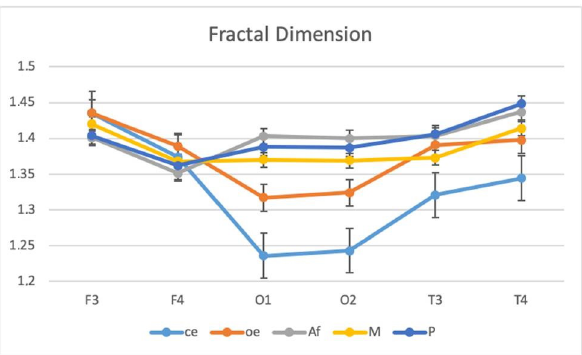
Figure 2. Average values of the fractal dimension in each electrode (F3, F4, O1, O2, T3, and T4) for the five types of EEG (closed eyes (ce), open (oe), Afghanistan-type driving (Af), Mali-type driving (M), and training track (P)).